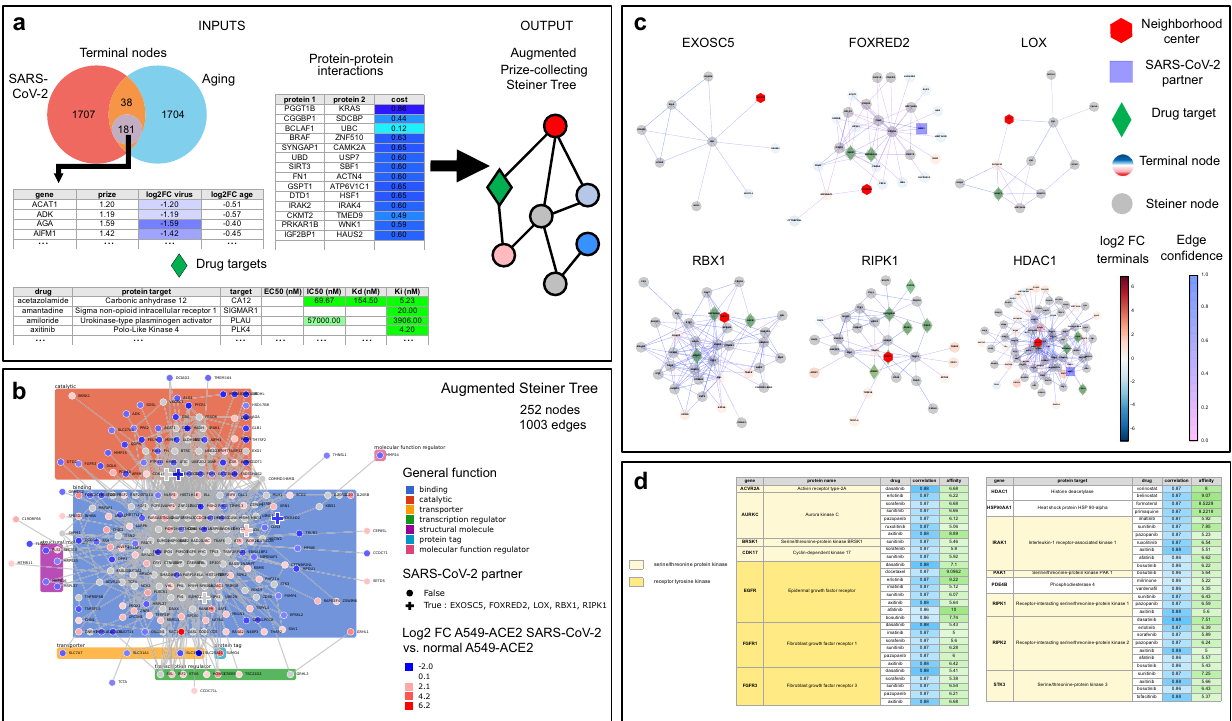
Fig. 4 Drug target discovery via Steiner tree analysis to identify putative molecular pathways linking differentially expressed genes in SARS-CoV-2 infection and aging. a The general procedure takes as input a list of genes of interest (terminal nodes) with prizes indicating their respective importance, a protein – protein interaction (PPI) network with edge cost/con fi dence information (e.g., from IRefIndex v14 42 , edge cost shown by blue shading), and a list of drugs of interest along with their protein targets and available activity constants (e.g., from DrugCentral 44,45 , activity constants shown by green shading). In this study, we consider 181 terminal nodes, shown as a purple circle in the Venn diagram (of which 162 are present in the PPI network) corresponding to genes differentially expressed in SARS-CoV-2 infection (red circle) and aging (blue circle) from Fig. 2 that are either upregulated in both SARS-CoV-2 infection and aging or downregulated in both SARS-CoV-2 infection and aging. The prize of a terminal node equals the absolute value of its log 2 -fold change in SARS-CoV-2-infected A549-ACE2 cells versus normal A549-ACE2 cells (shown in purple shading) based on the data from ref. 23 . Terminals and PPI data are processed using OmicsIntegrator2 30 to output the disease interactome, i.e., the subnetwork induced by a Steiner tree, with drug targets indicated by green diamonds and terminal nodes colored according to their prizes. Gray nodes represent Steiner nodes. b Interactome obtained using this procedure. Proteins are grouped by general function (colored boxes in the background) and marked with a cross if they are known to interact with SARS-CoV-2 proteins based on data from 6 . c 2-Nearest-neighborhoods of nodes of interest (denoted by a red hexagon) in the interactome. Proteins known to interact with SARS-CoV-2 are denoted by blue squares, drug targets are denoted as green diamonds, terminal nodes are colored according to their log 2 -fold change in SARS-CoV-2-infected A549-ACE2 cells versus normal A549-ACE2 cells, Steiner nodes appear in gray. Edges are colored according to edge con fi dence, which is thresholded to improve readability (see “ Methods ” ). d Table of drug targets and corresponding drugs in the interactome. Selected drugs are FDA-approved, high af fi nity (at least one of the activity constants K i , K d , IC50 or EC50 is below 10 μ M), and match the SARS-CoV-2 signature well (correlation > 0.86). The af fi nity column displays (and is colored by) (cid:1) log 10 ð activity Þ . The correlation column displays (and is colored by) correlations between drug signatures and the reverse signature of SARS-CoV-2 infection based on the overparameterized autoencoder embedding. Discovered drug targets generally fall into two categories: serine/threonine protein kinases (light yellow) and receptor tyrosine kinases (dark yellow). The remaining drug targets are in white. The protein name corresponding to each gene is